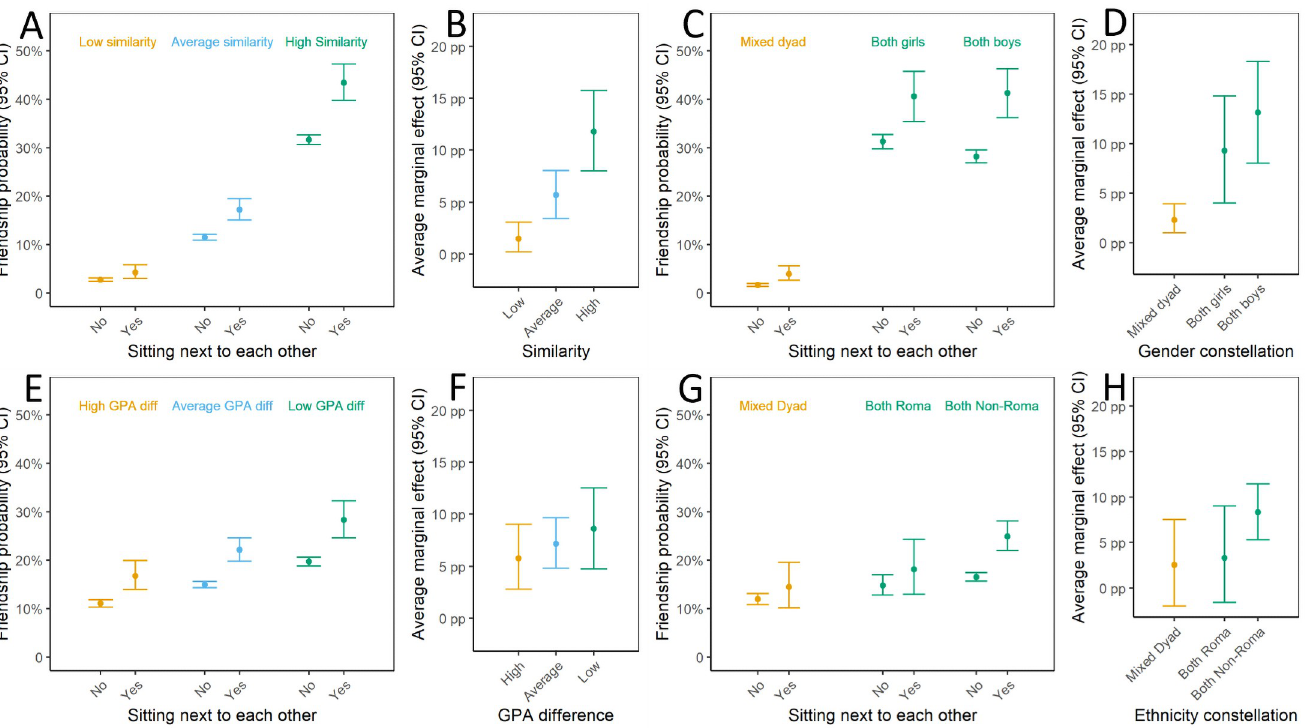
Fig 1. Model predictions for the effect of sitting next to each other on reciprocated friendships. Left column displays the predicted friendship probabilities (predictive margins); right column displays the corresponding average marginal deskmate effects (differences in the predicted friendship probabilities) in percentage points. (A) and (B): effect modification by overall similarity (low: -1 SD, high: +1 SD on Gower’s similarity index based on gender, ethnicity, and baseline GPA). (C) and (D): effect modification by the gender composition of the dyad. (E) and (F): effect modification by absolute GPA difference between the students (low: -1 SD, high: +1 SD relative to the mean absolute difference). (G) and (H): effect modification by the ethnic (Roma/non-Roma) composition of the dyad.